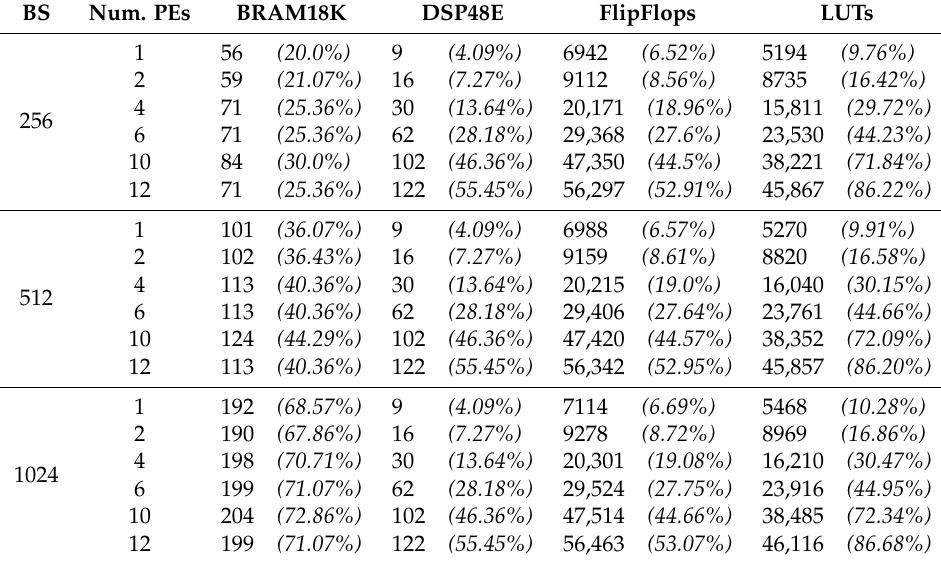
Table 4. Post-Synthesis results for the different versions of the HyperLCA Transform for a Xilinx Zynq-7020 programmable SoC and image block up to 180 bands.